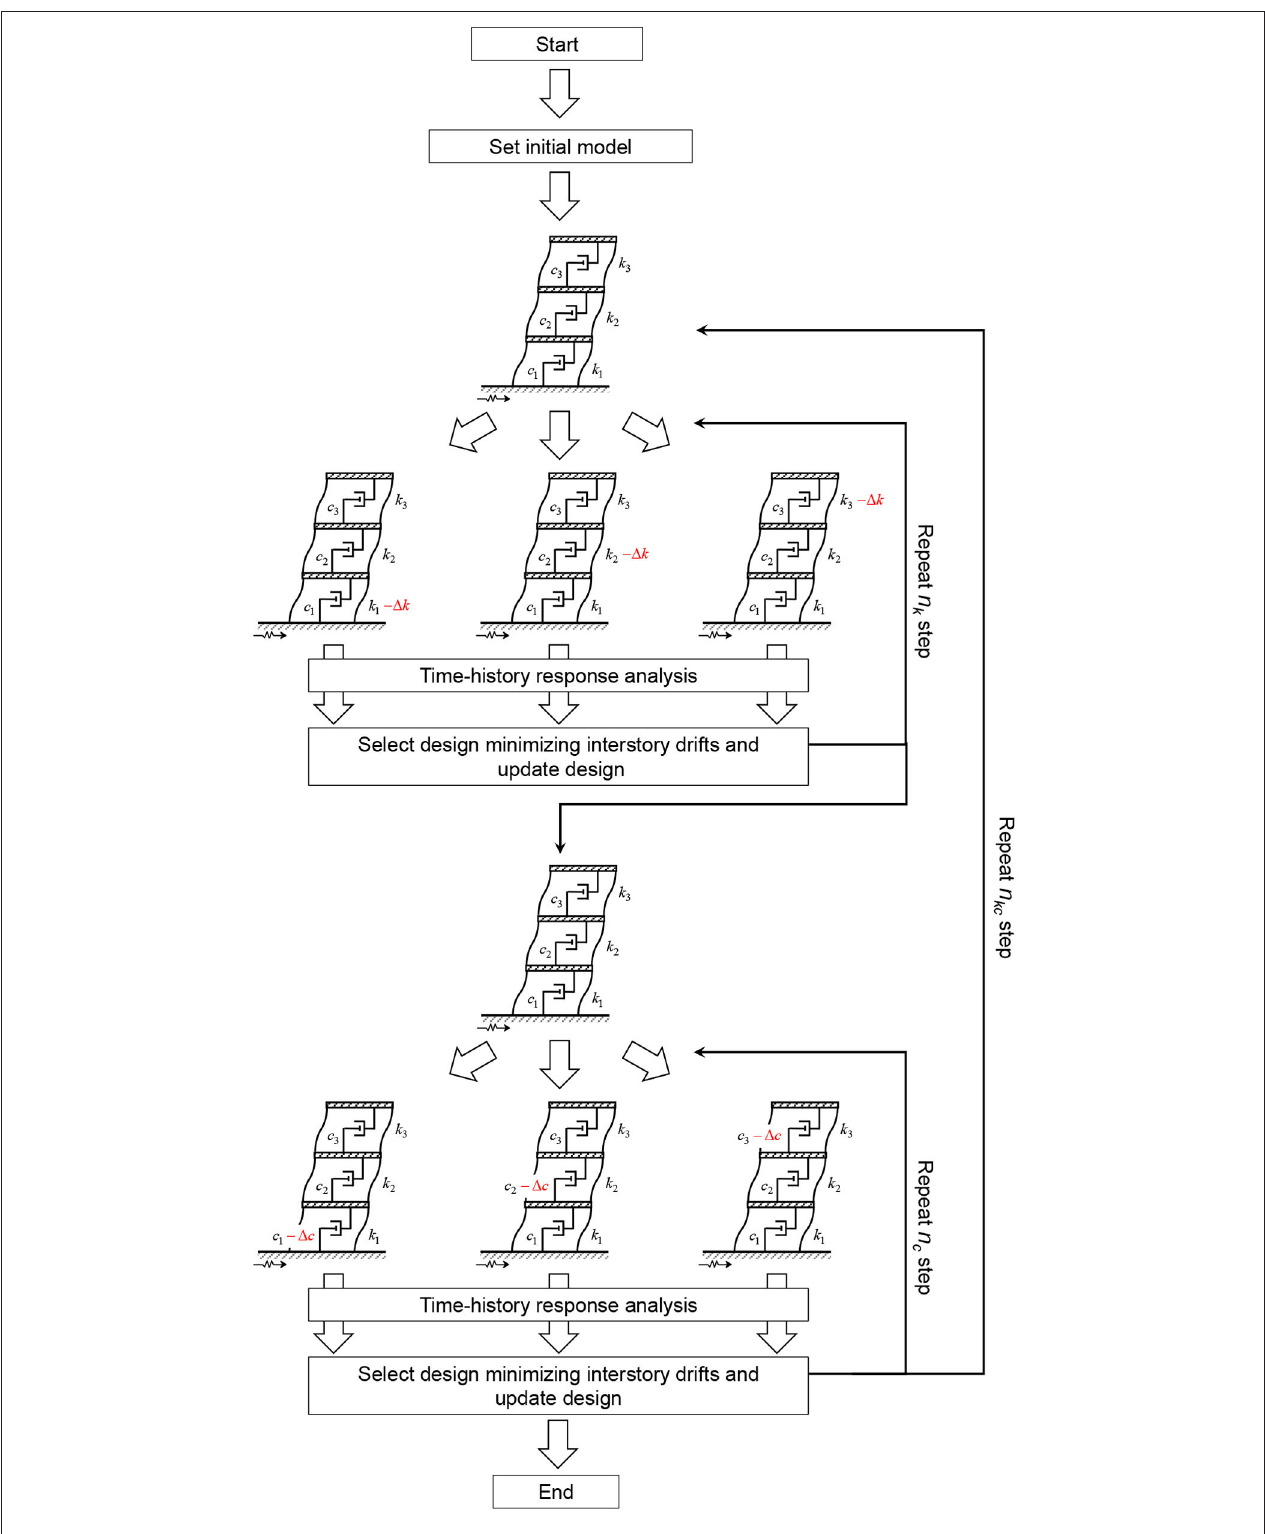
FIGURE 2 | Schematic diagram of proposed solution algorithm.